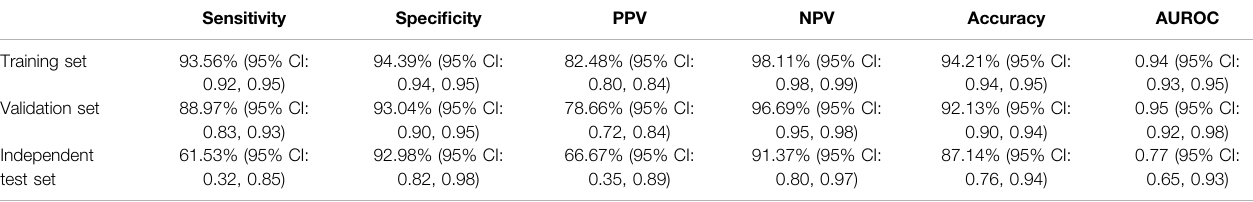
TABLE 2 | Ef fi cacy of the DCCN model.